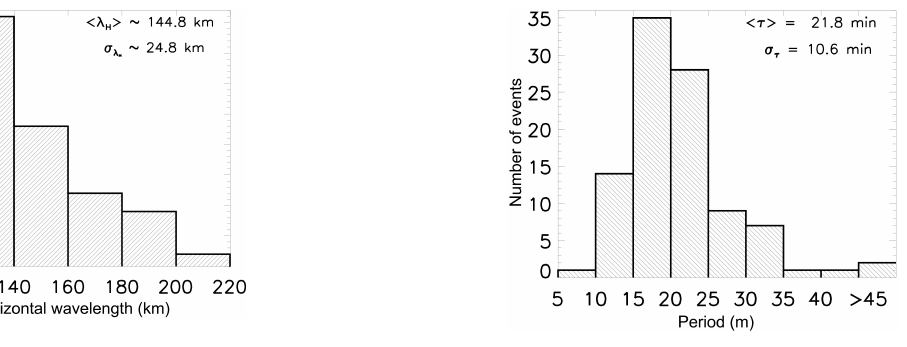
Figure 3. Histogram for the observed